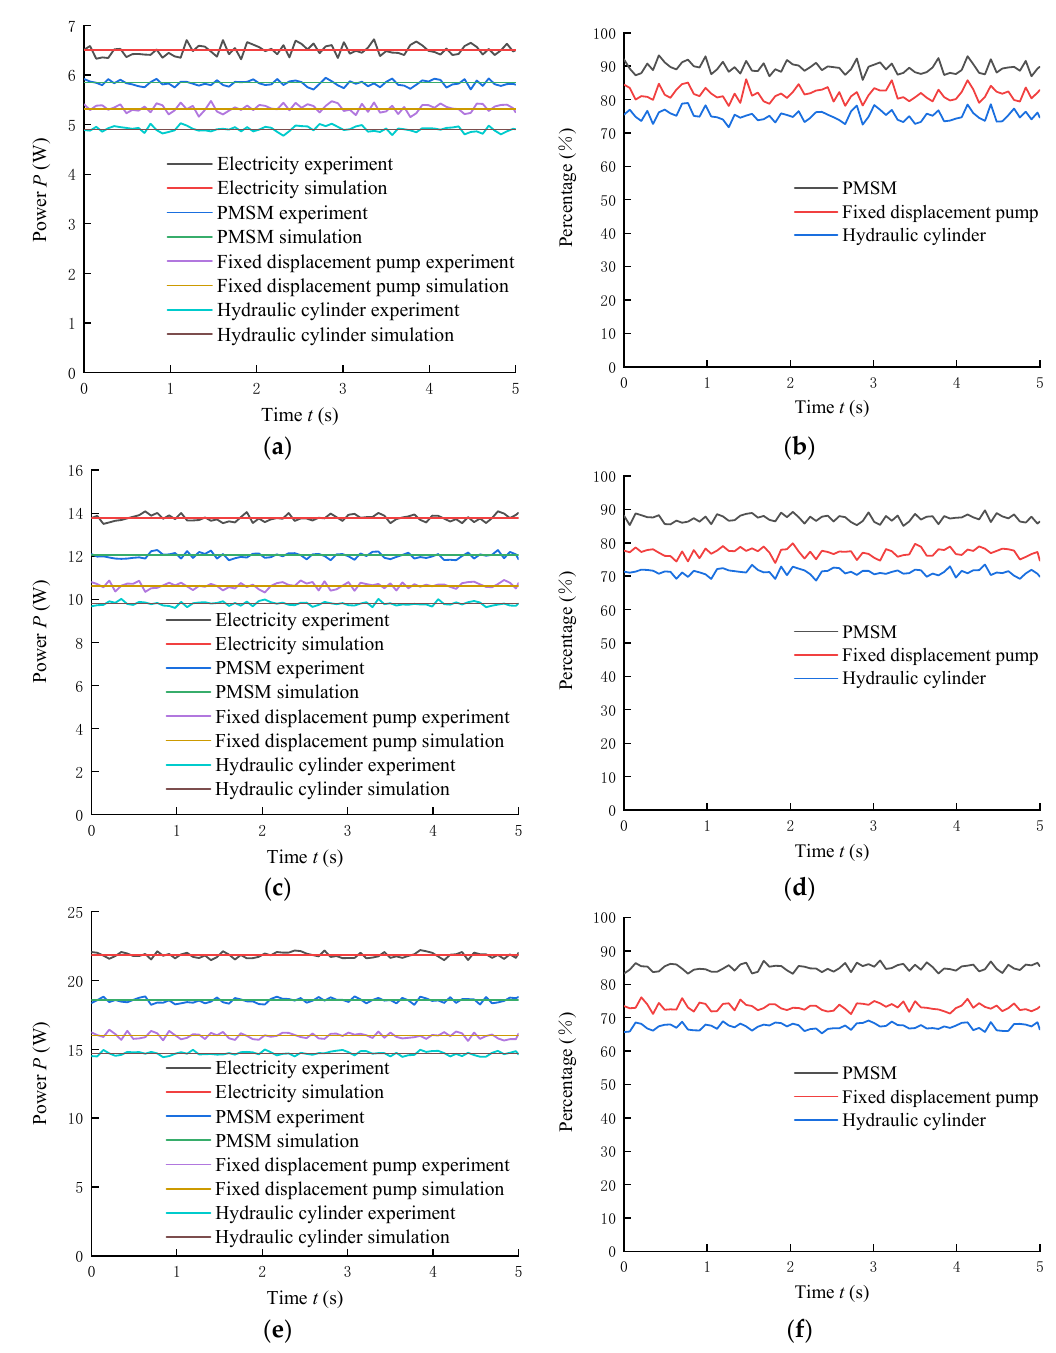
Figure 11. Simulation and experimental power comparison curves and energy output ratio curves of key components of the system under different load forces: ( a ) Power comparison curve under 70 kN load; ( b ) Energy output ratio curve under 70 kN load; ( c ) Power comparison curve under 140 kN load; ( d ) Energy output ratio curve under 140 kN load; ( e ) Power comparison curve under 210 kN load; ( f ) Energy output ratio curve under 210 kN load.